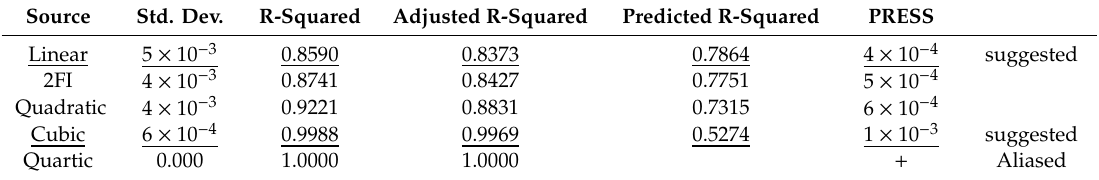
Table 11. Model summary statistics for density.